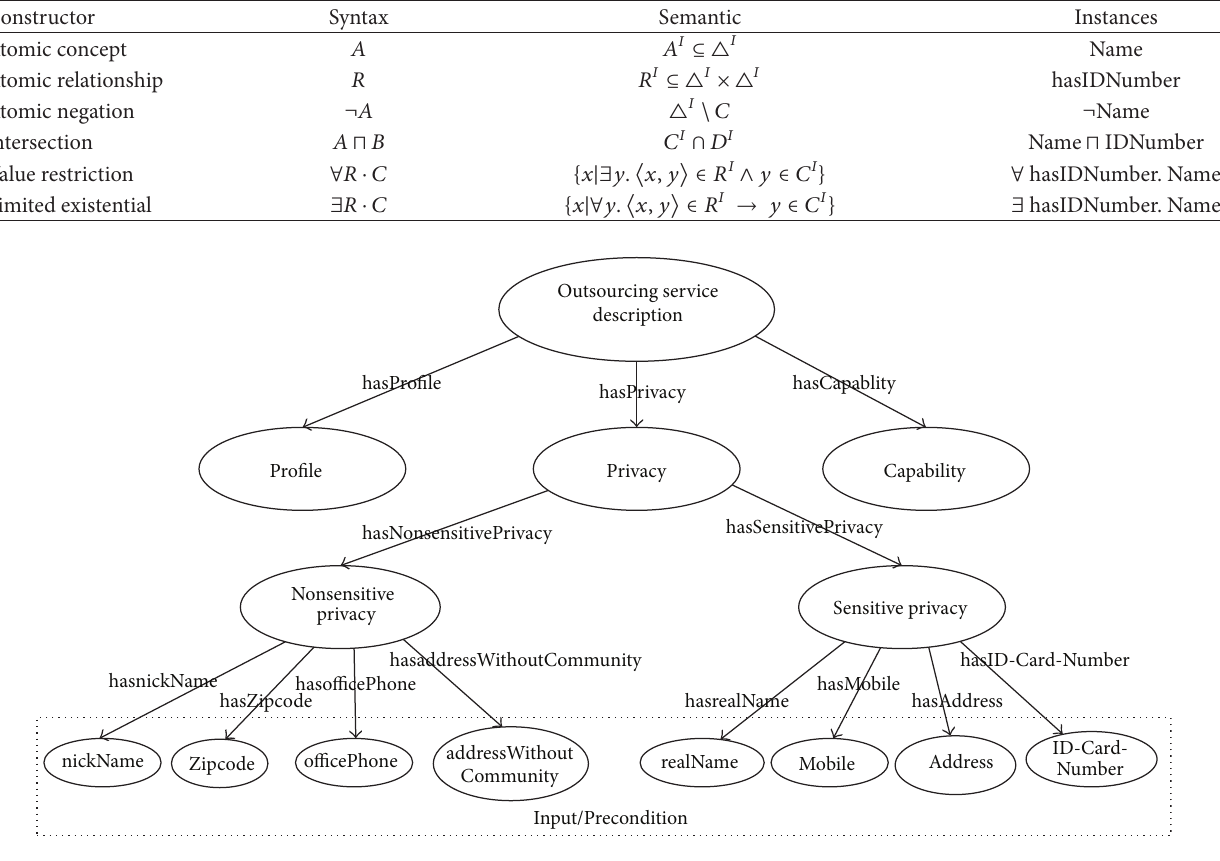
Table 2: Syntax and semantic of ALC.